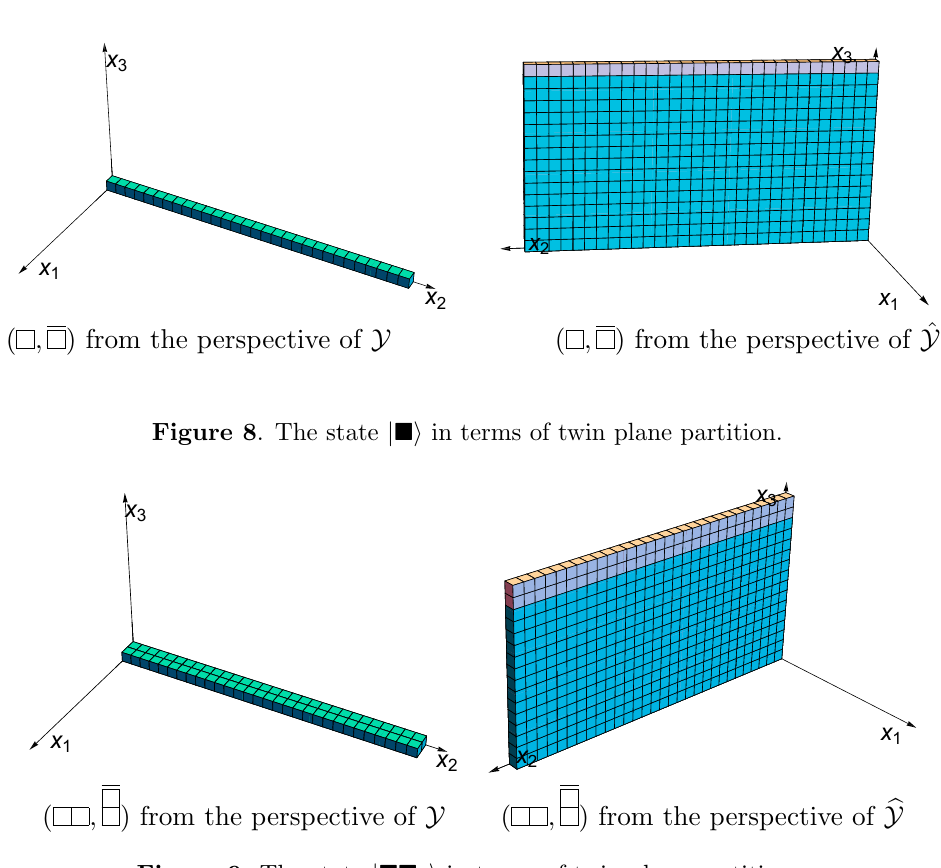
Figure 9 . The state